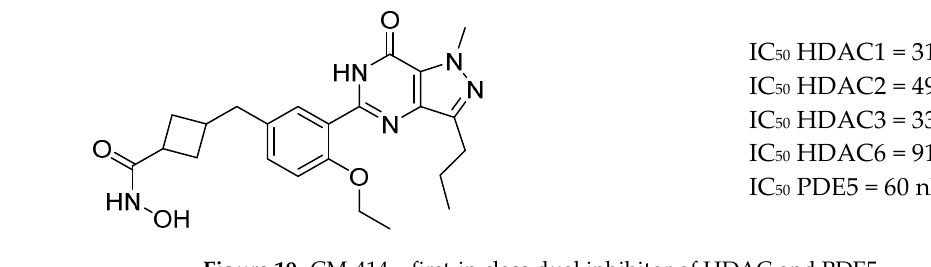
Figure 19. CM-414—first-in class dual inhibitor of HDAC and Figure 19. CM-414 - first-in class dual inhibitor of HDAC and PDE5. Figure 19. CM-414 - first-in class dual inhibitor of HDAC and PDE5.